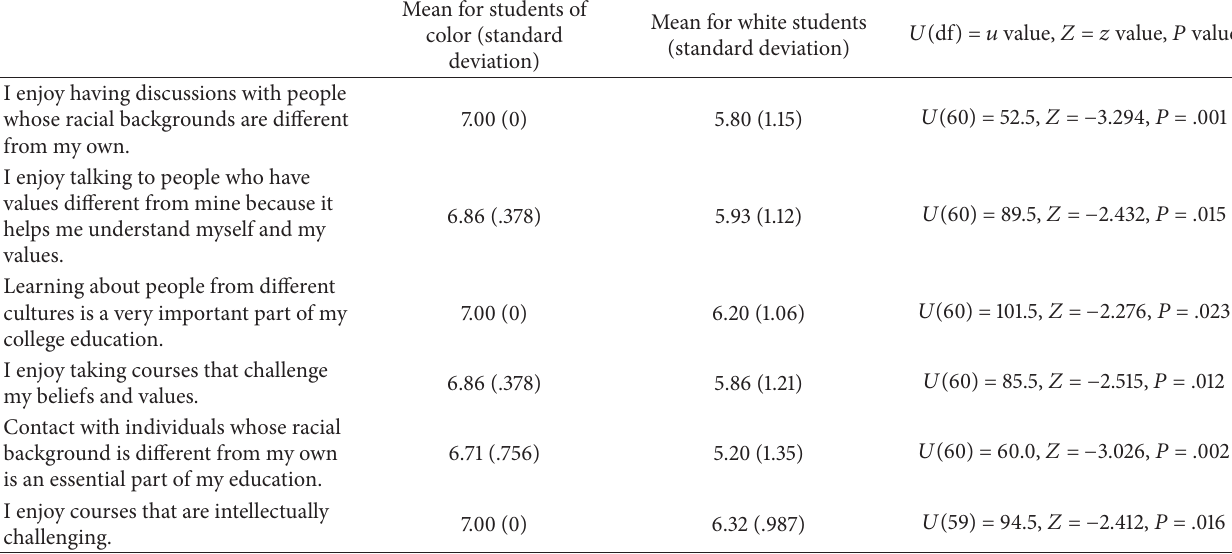
Table 4: Mean and Mann-Whitney 𝑈 test results (the openness to diversity/challenge scale).